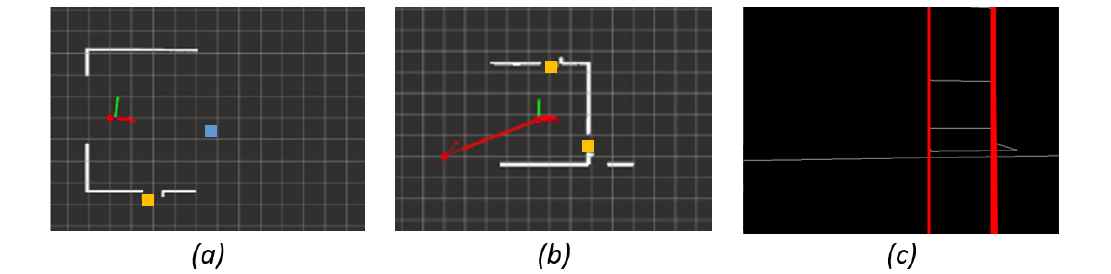
Figure 4. Semantic frontier classification: ( a ) a free area and a transit area are detected; ( b ) two transit areas, one of them is successfully detected as door despite the detection of a wall behind it; and ( c ) door frames detection based on Hough Transform is